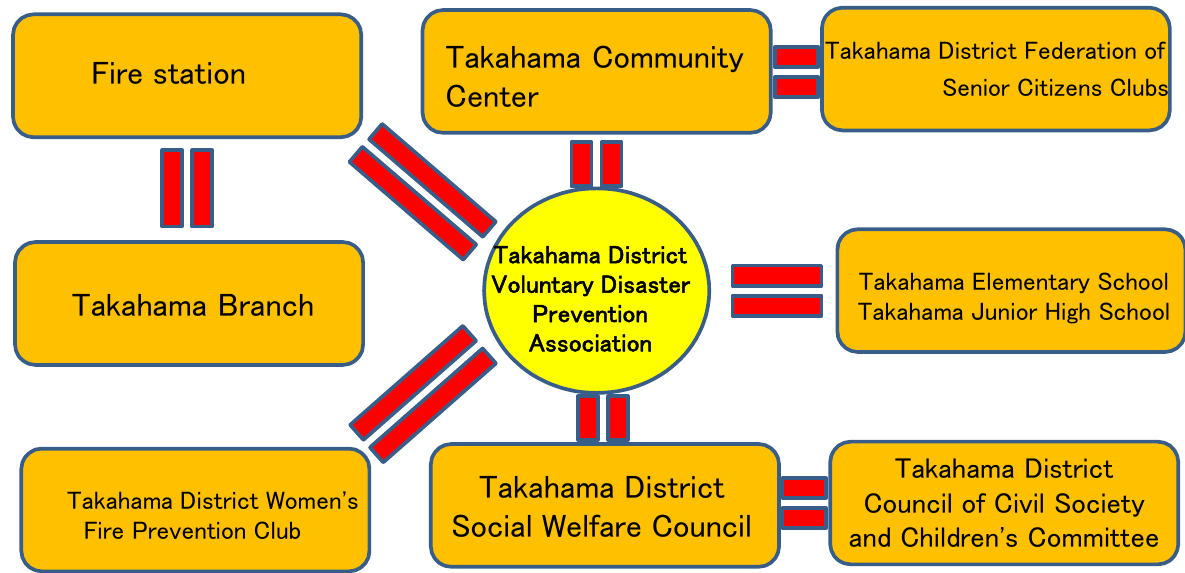
Figure 8. Cooperation system based on voluntary disaster prevention organizations [51].